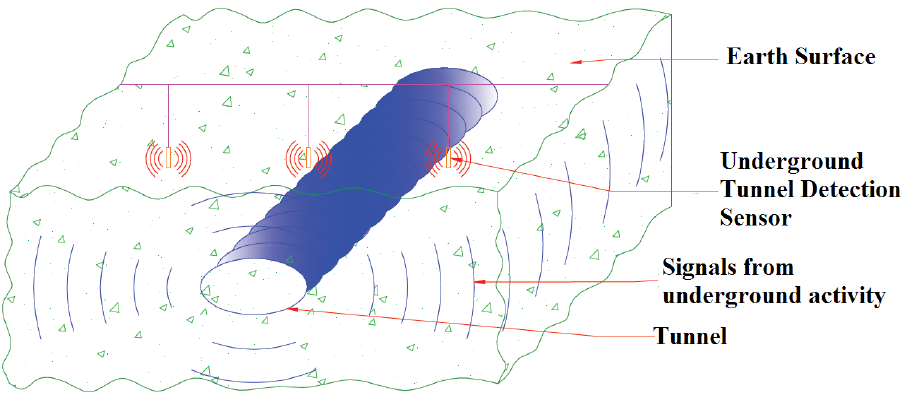
Figure 5. Detection method for tunnel